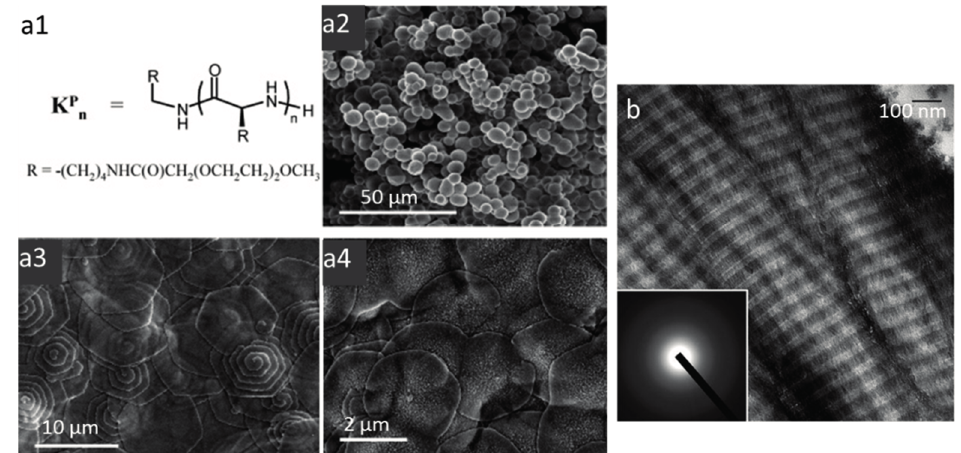
Figure 3. ( a1 ) Chemical structure of PLL (K p n ) and Scanning Electron Microscopy (SEM) images of ( a2 ) K p 56 spheres, ( a3 , a4 ) K p 264 and K p 400 hexagonal plates. Copyright